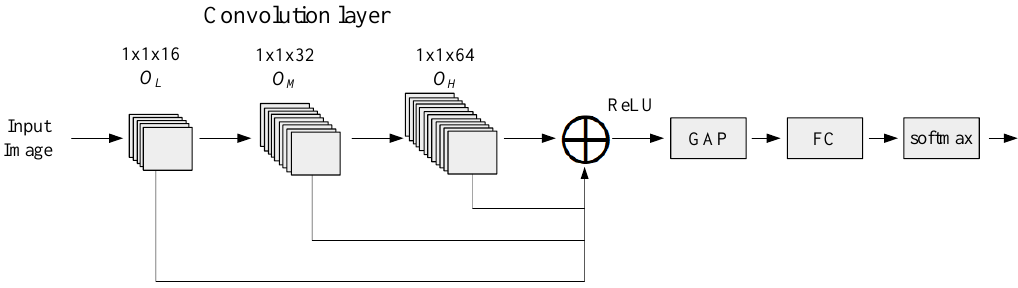
Figure 9. A block diagram of the multi-layer hierarchical fusion residual network for ground object classification.